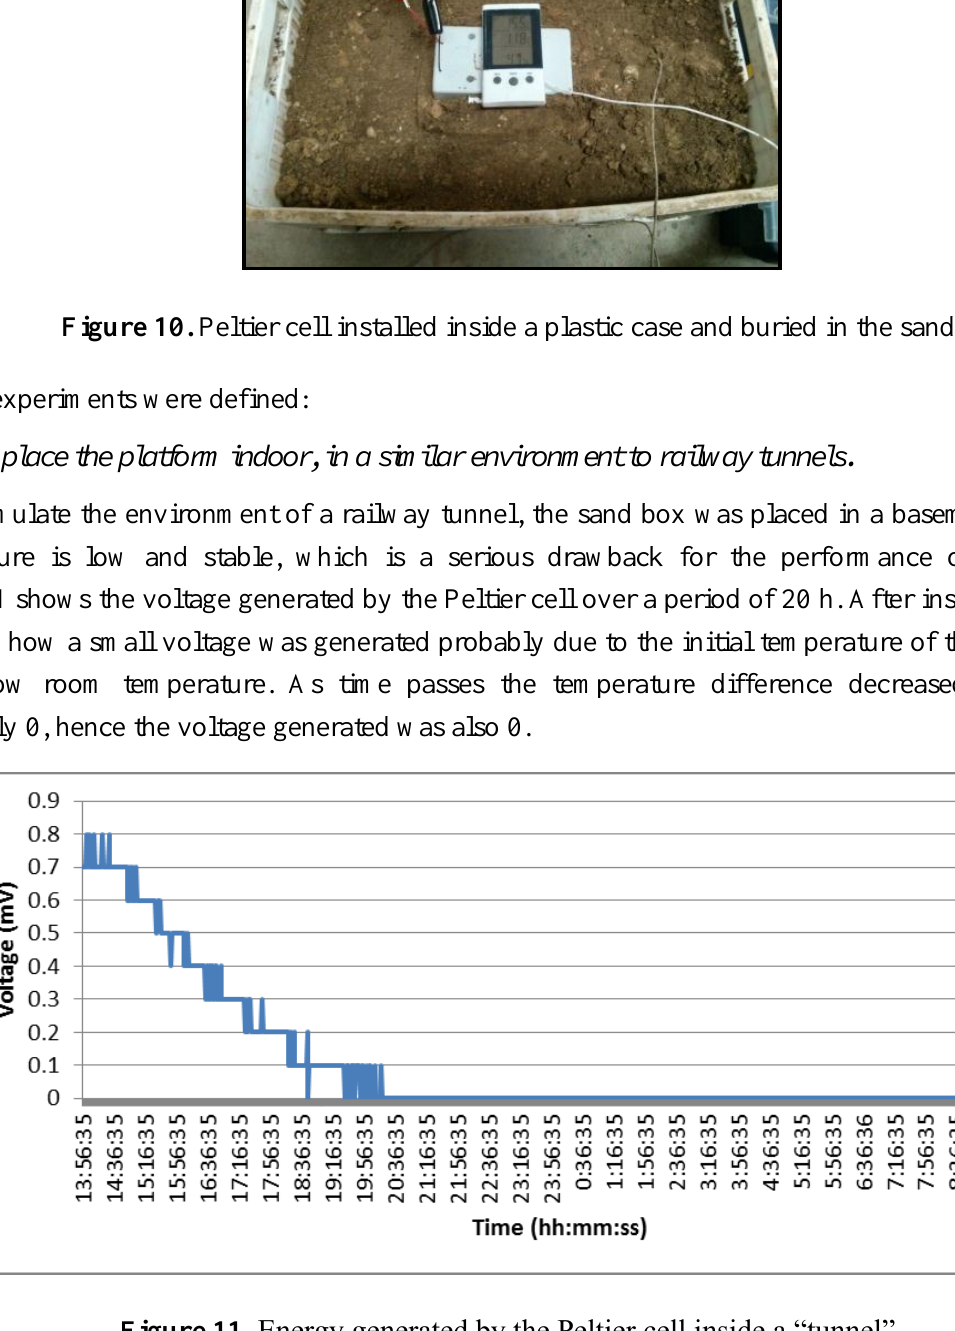
Figure 11. Energy generated by the Peltier cell inside a